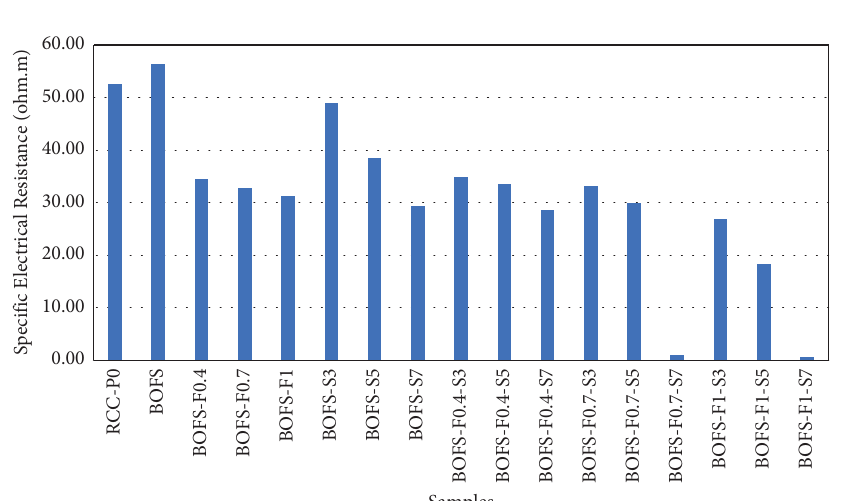
Samples Figure 9: Electrical resistance.